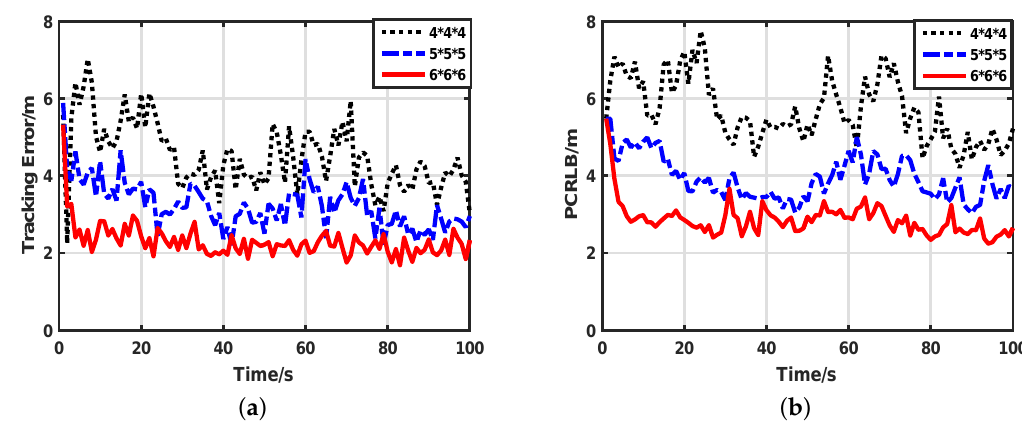
Figure 7. Target tracking performance of our scheme with 1-bit quantized measurements in different density networks. ( a ) Target tracking error with 1-bit quantized measurements; ( b ) posterior Cramer–Rao lower bound (PCRLB) with 1-bit quantized measurements.